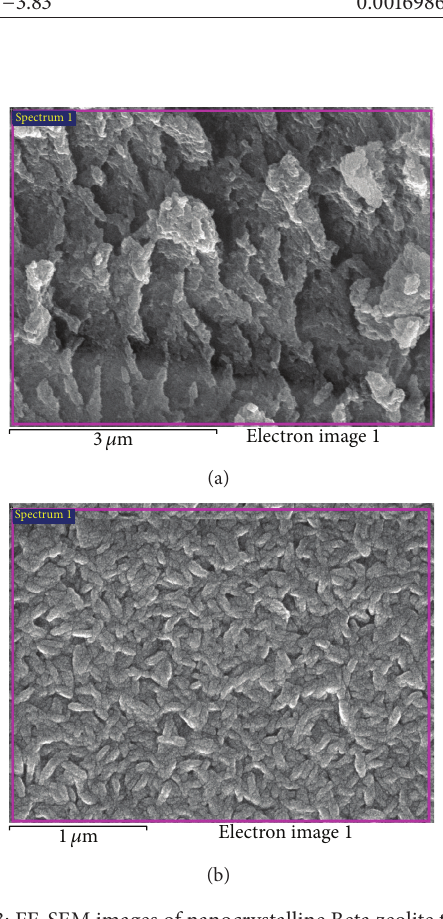
Figure 3: FE-SEM images of nanocrystalline Beta zeolite thin film. (a) Before steaming; (b) after